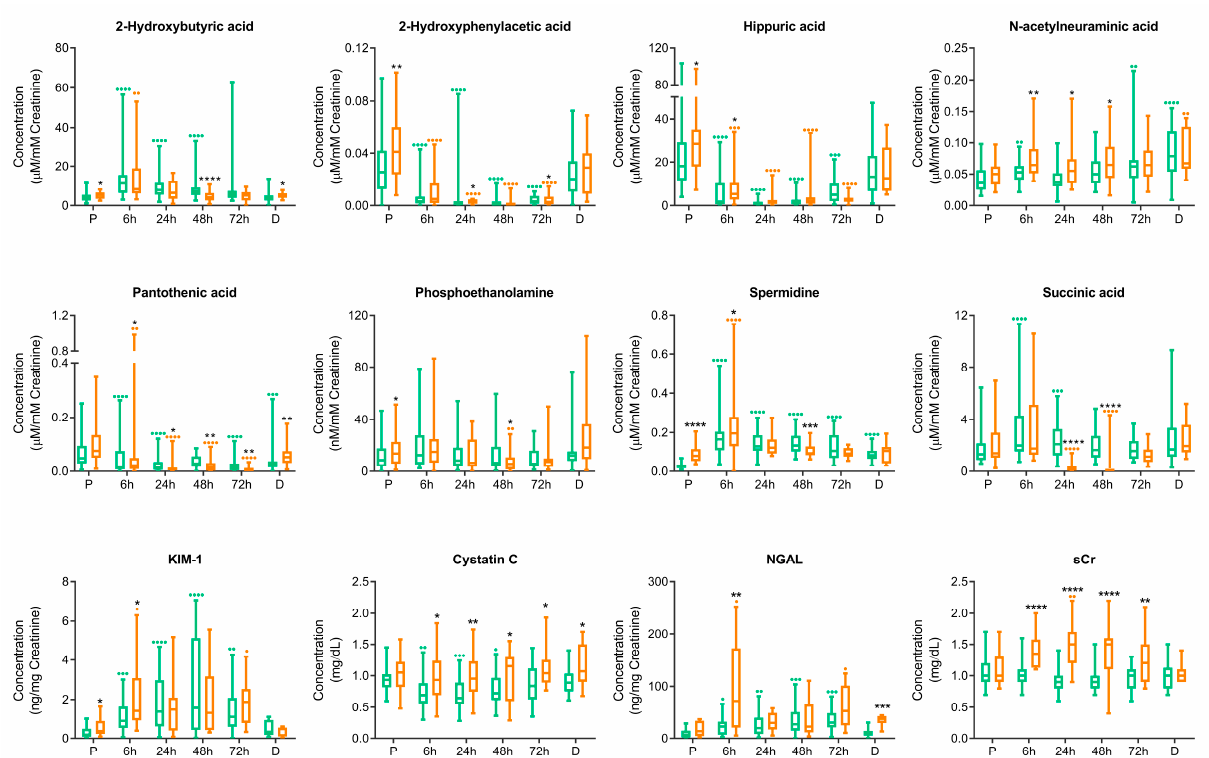
Figure 1. Concentration values variation over time of molecular features identified in association with post-surgery AKI. Comparison of levels between CVS-C and CVS-AKI subjects is represented in boxplot (min–max) at each point of time (pre-surgery: P; post-surgery: 6, 24, 48, 72 h and discharge (D)). Concentration levels over time of CVS-C subjects are shown in green and levels in CVS-AKI subjects are shown in orange. Mann–Whitney statistical test was performed to compare clinical groups at each timepoint (CVS-C vs. CVS-AKI): * p < 0.05, ** p < 0.01, *** p < 0.001, **** p < 0.0001 (significance in black). The Kruskal–Wallis statistical test was performed to identify significant variations between post-surgery points of time (6, 24, 48, 72 h or D) and pre-surgery levels (P): • p < 0.05, •• p < 0.01, ••• p < 0.001, •••• p < 0.0001 (significance in green for CVS-C values and in orange for CVS-AKI